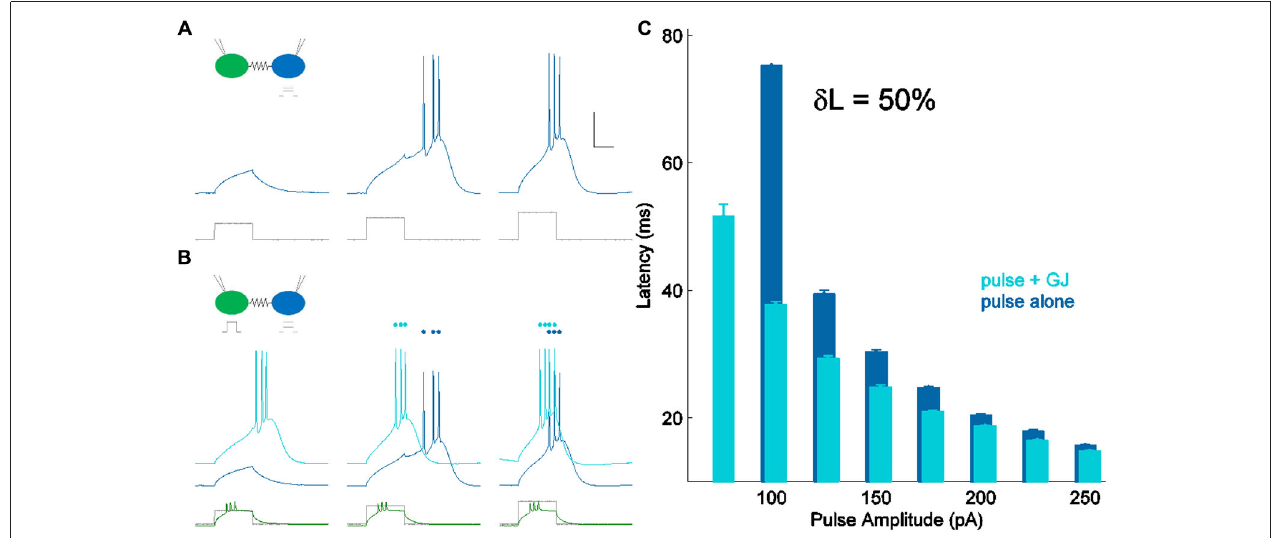
FIGURE 2 | Measuring δ L, latency modulation . (A) Spiking in one cell of a coupled pair (blue) in response to current pulses of increasing amplitude (lower, shown in gray). Scale bar 25 ms, 20 mV. The coupled cell was quiet and is not shown. (B) Spiking in the same cell (light blue) for the same current pulses as in (A) (lower, shown in gray), with the coupled neighbor also spiking (lower, shown in green). Responses from (A) are repeated, vertically offset for clarity (darker blue). (C) Latency of spiking in (A) (pulse alone) and (B) (pulse + GJ input) plotted against input amplitude. For peri-threshold inputs (100 pA) in this cell, δ L, the percentage change in perithreshold spike latency, was 50%.